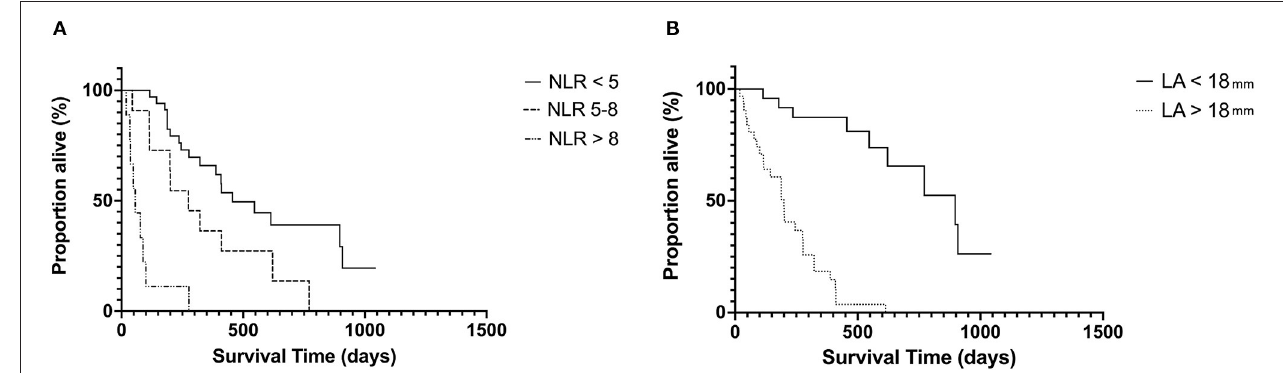
FIGURE 2 | Kaplan–Meier curves showing the effect of NLR (A) and LA size (B) on survival in cats with hypertrophic cardiomyopathy at the univariable level. NLR, neutrophil-to-lymphocyte ratio; LA, left